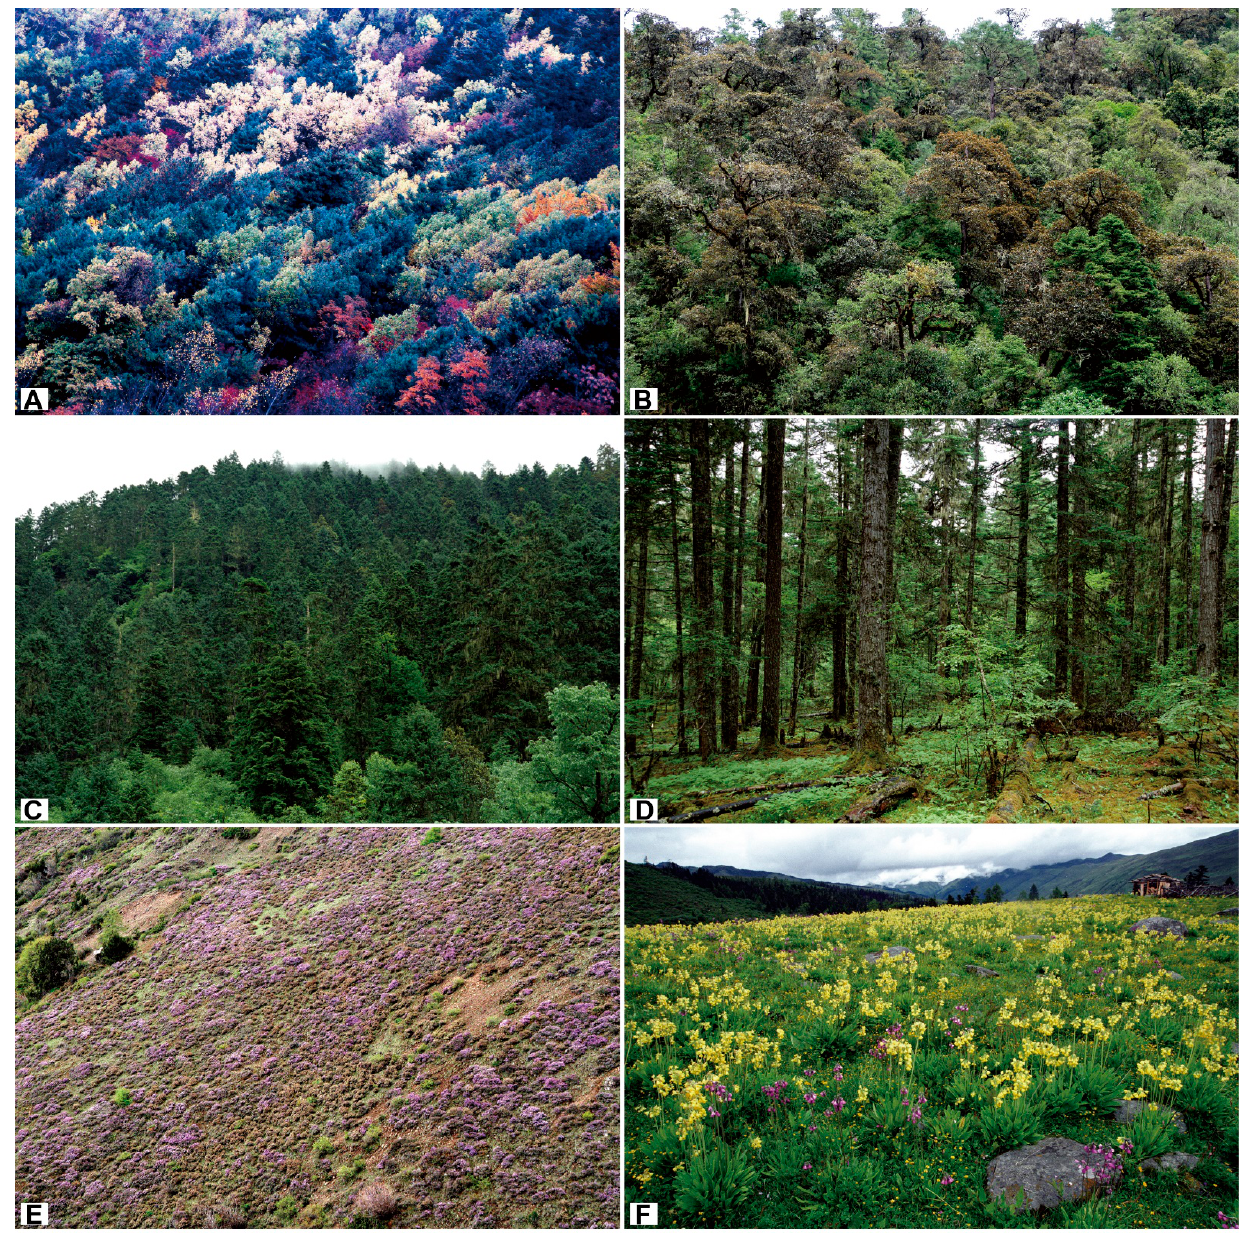
Figure 5. ( A ), Temperate coniferous and deciduous broad-leaved mixed forest in northern Yunnan; ( B ), cold temperate coniferous and sclerophyllous oak mixed forest in northern Yunnan; ( C ), cold temperate coniferous forest in northern Yunnan; ( D ), understory of the cold temperate coniferous forest in northern Yunnan; ( E ), alpine Rhododendron shrubs in northern Yunnan; ( F ), alpine meadows in northern Yunnan.